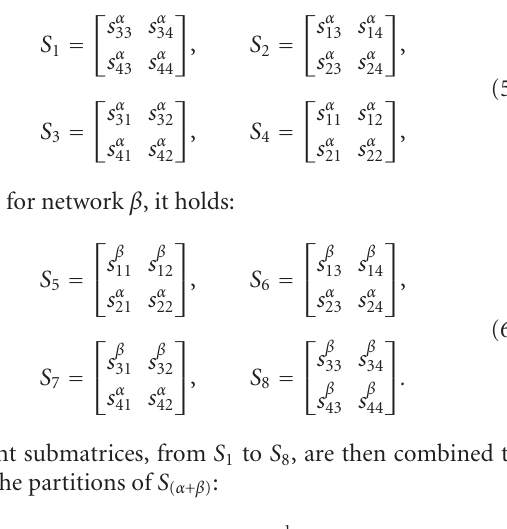
(dashed lines), once applied the optimized fitting